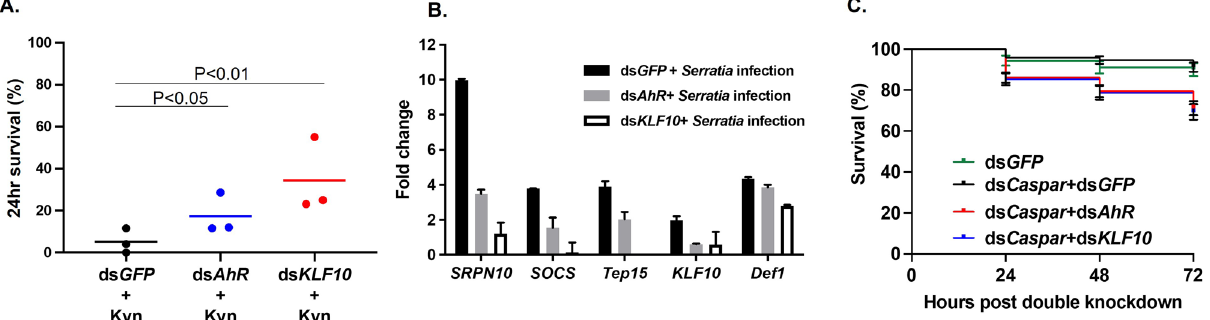
Figure 6. KLF10 is mediating immunomodulation downstream of AhR. ( A ) The Kyn-mediated immune suppression was reversed by dsAhR and dsKLF10, shown by the survival post bacterial challenge. ( B ) qPCR results of the genes in the dsAhR or dsKLF10 cohorts . ( C ) The effect of dsAhR and dsKLF10 on the survival of mosquitoes in which the IMD was overactivated by dsCaspar, no bacterial challenge was given. No significant difference was observed when dsCaspar + dsGFP was compared to dsGFP (Mantel–Cox test, P > 0.05). The survival was reduced in the co-silencing mosquitoes (Mantel–Cox test, P < 0.001). Each line represents pooled data from 5 cohorts with standard error